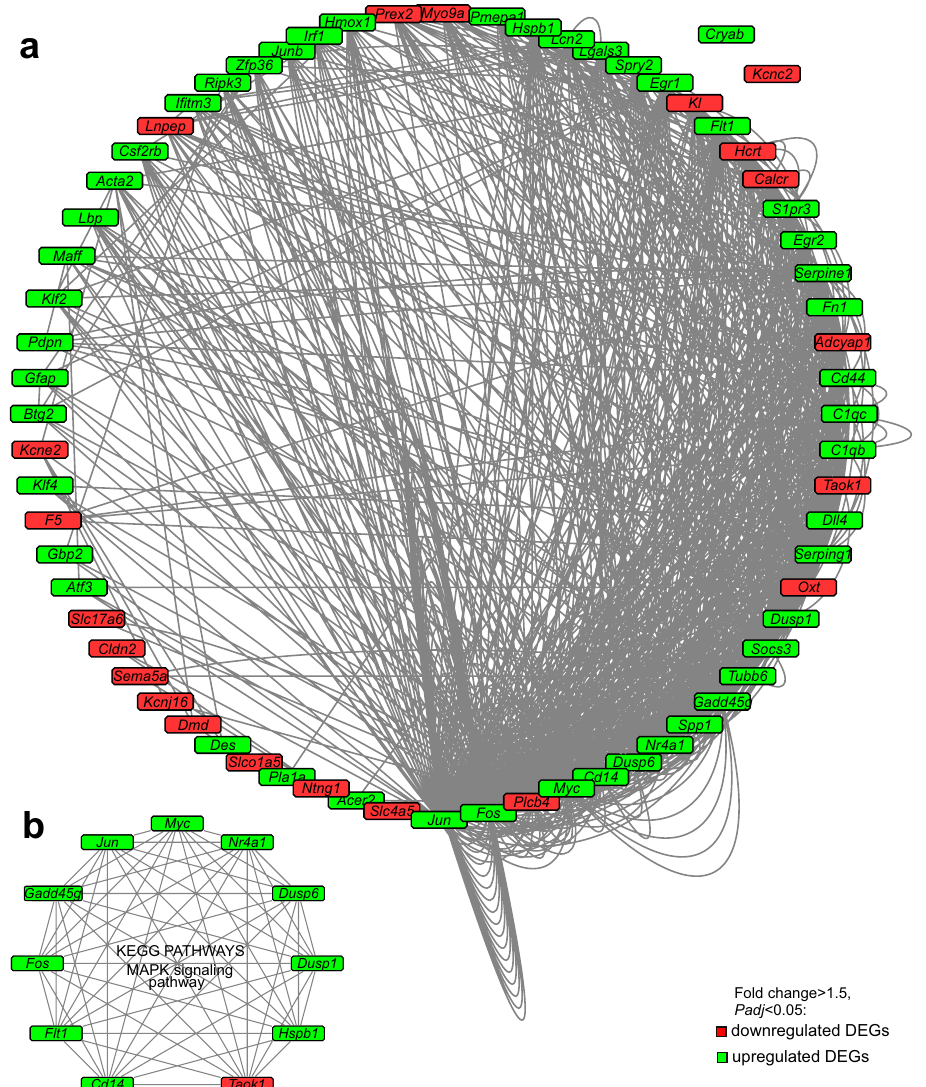
Figure 4. The functional networks of the DEGs with codirectionally changed mRNA levels in the two brain hemispheres after tMCAO. ( a ) In 69 of the 114 DEGs analyzed, significant associations with signaling pathways were observed using DAVID. ( b ) The DEGs associated with the MAPK signaling pathway (KP). Only those DEGs that had codirectionally changed mRNA levels (cutoff > 1.5; Padj < 0.05) in the comparisons IR-i vs. SO-r and IR-c vs. SO-l were selected for analysis. Only those pathways associated significantly ( Padj < 0.05) with DEGs in the comparison IR-i vs. SO-r were selected for analysis. The networks were constructed using Cytoscape 3.8.2 software. The nodes indicate DEGs. Each line connecting the nodes indicates an involvement of the protein product of the corresponding gene in the signaling pathway